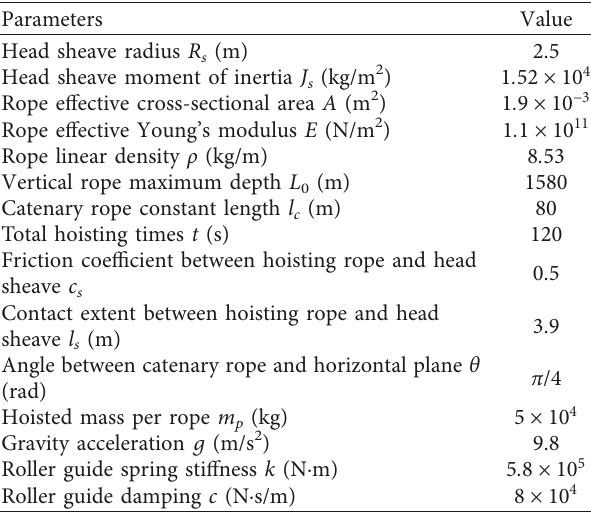
Table 1: Winding hoist